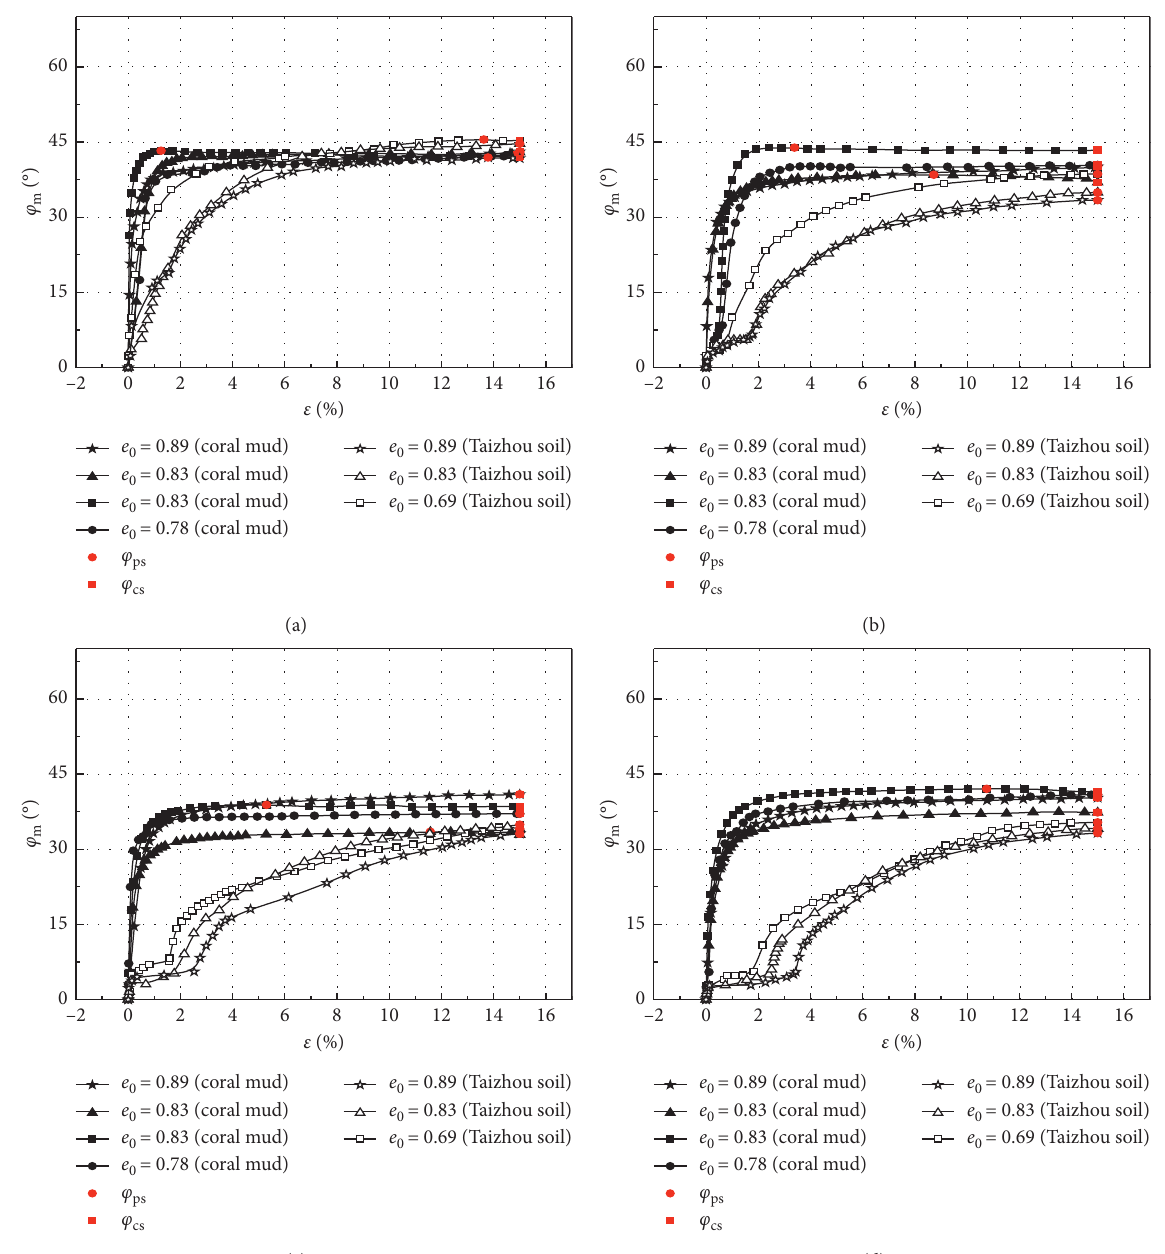
Figure 13: Mobilized friction angle of coral mud and Taizhou soil: (a) 100kPa, (b) 200kPa, (c) 300kPa, and (d)